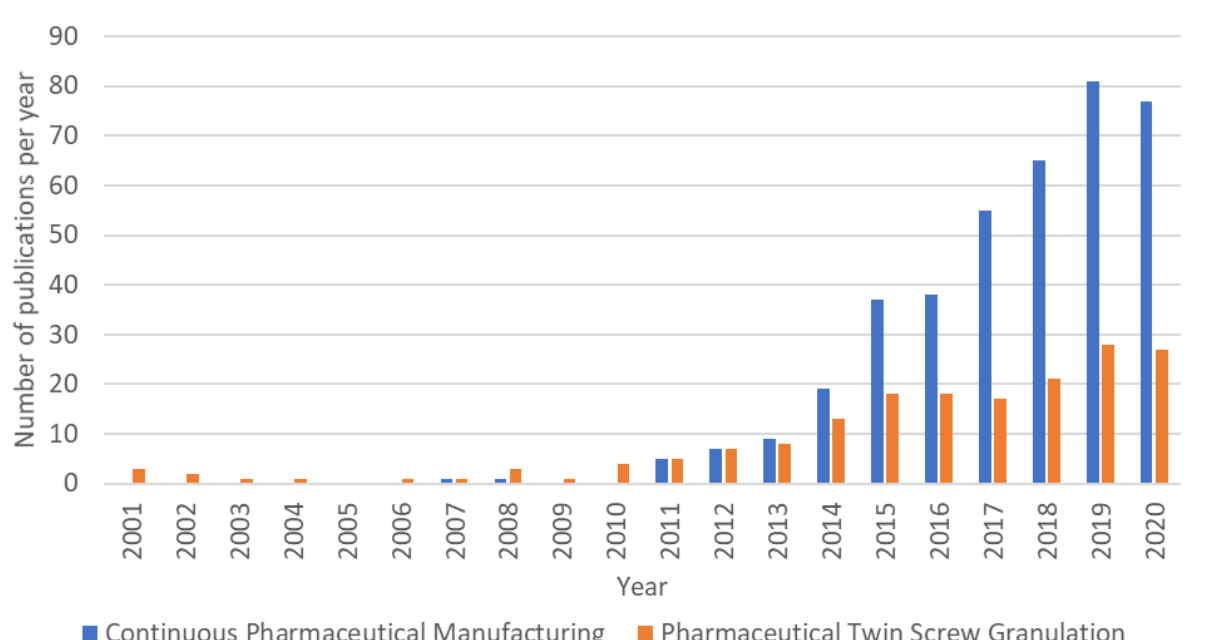
Table 1. Overview of research papers on twin screw wet granulation evaluating formulations consisting of an API and a filler combination of MCC and lactose.